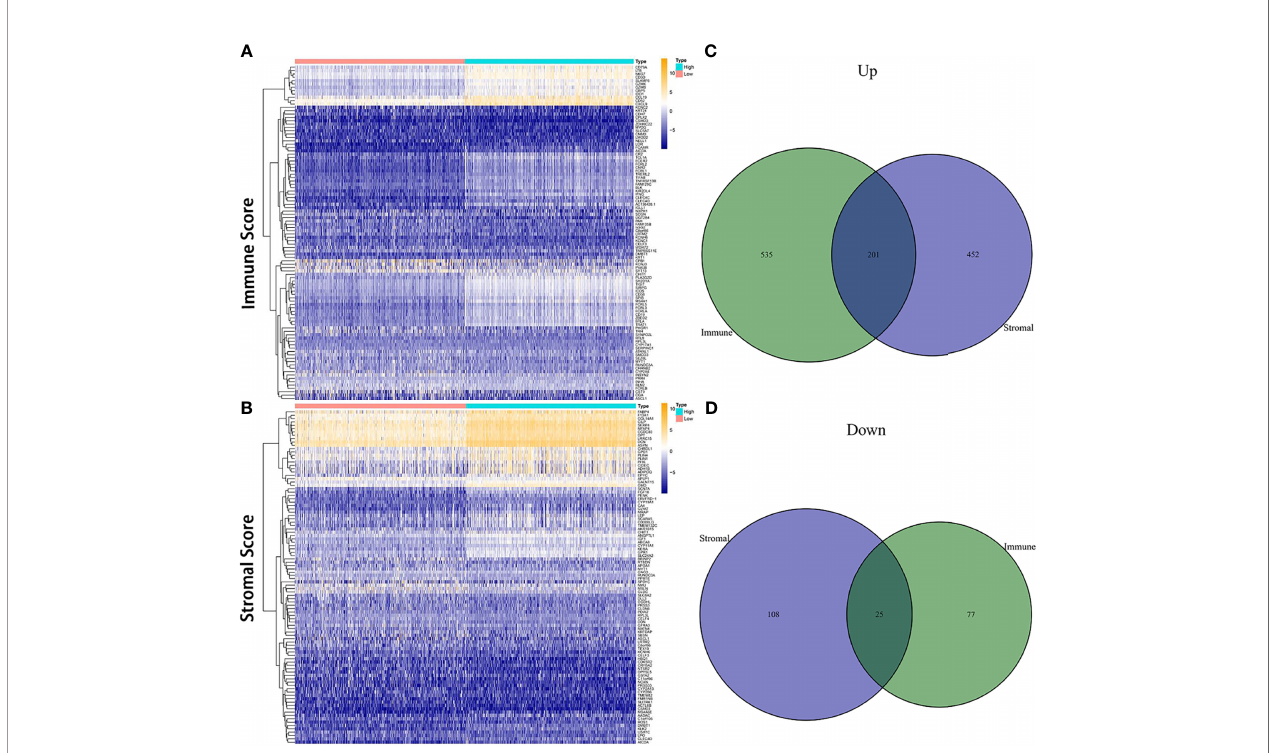
FIGURE 3 | Heatmap and Venn diagrams for DEGs. (A, B) Heatmap for DEGs derived from comparing high score group and low score group in Immune Score and Stromal Score, respectively. Differentially expressed genes were determined by the Wilcoxon rank-sum test. (C, D) Venn diagrams for shared DEGs, including both upregulated and downregulated genes, in the Immune Score and Stromal Score